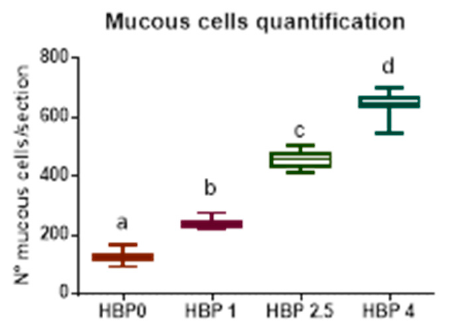
Figure 1. Abundance of mucous cell in medium intestine. The number of mucous cells is reported as mean of the observations performed on three transversal intestinal sections from individual fish (n = 9) from the di ff erent experimental groups. Di ff erent letters indicate significant di ff erences among groups ( p < 0.05).